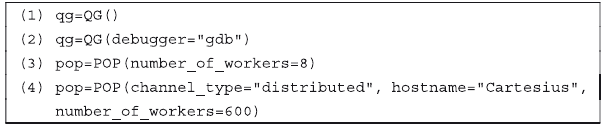
Figure 2. Examples of the instantiation of simulation codes within OMUSE. (1) Simple instantiation on a local machine of the QG code, (2) instantiation of a code inside a debugger, (3) local instan- tiation of an MPI-parallel code (POP), (4) instantiation of POP on a remote machine for a massively parallel high-resolution run through the distributed channel (see Sect.